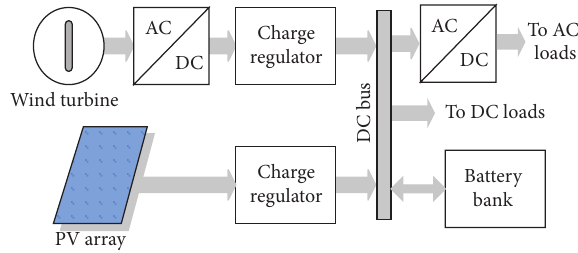
Figure 1: Hybrid energy system components. Figure 2: Single-diode mathematical model of a PV